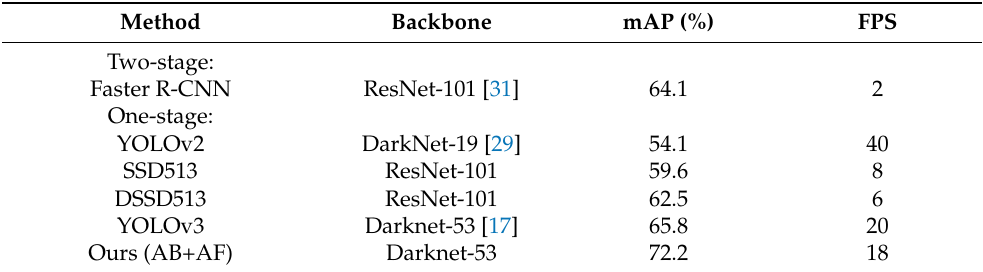
Table 3. Evaluation metric of the improved detector and other typical detectors on the infrared image dataset. AB: Anchor-based branches of the YOLOv3 detector. AF: Anchor-free branches of the improved FSAF